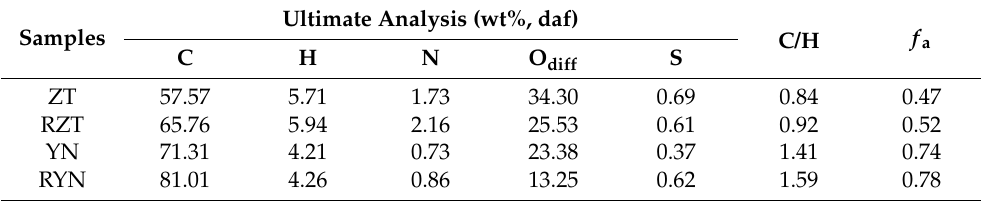
Table 1. Ultimate analysis of each component in ZT and RZT, YN and RYN a .